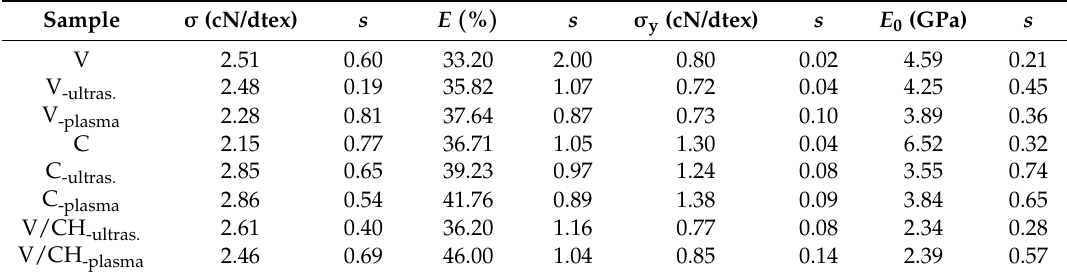
Table 3. Tensile properties: stress at break ( σ ), strain at break ( ε ), yield stress ( σ y ), elastic modulus ( E 0 ) of fibers; s-presents the standard